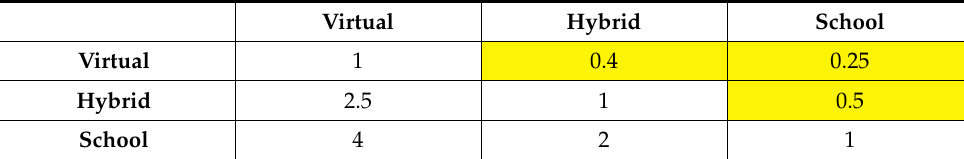
Table 6. Pairwise Comparison and Weights for the 3 Alternatives under the Economy Criterion. Virtual Hybrid School Virtual 1 0.4 0.25